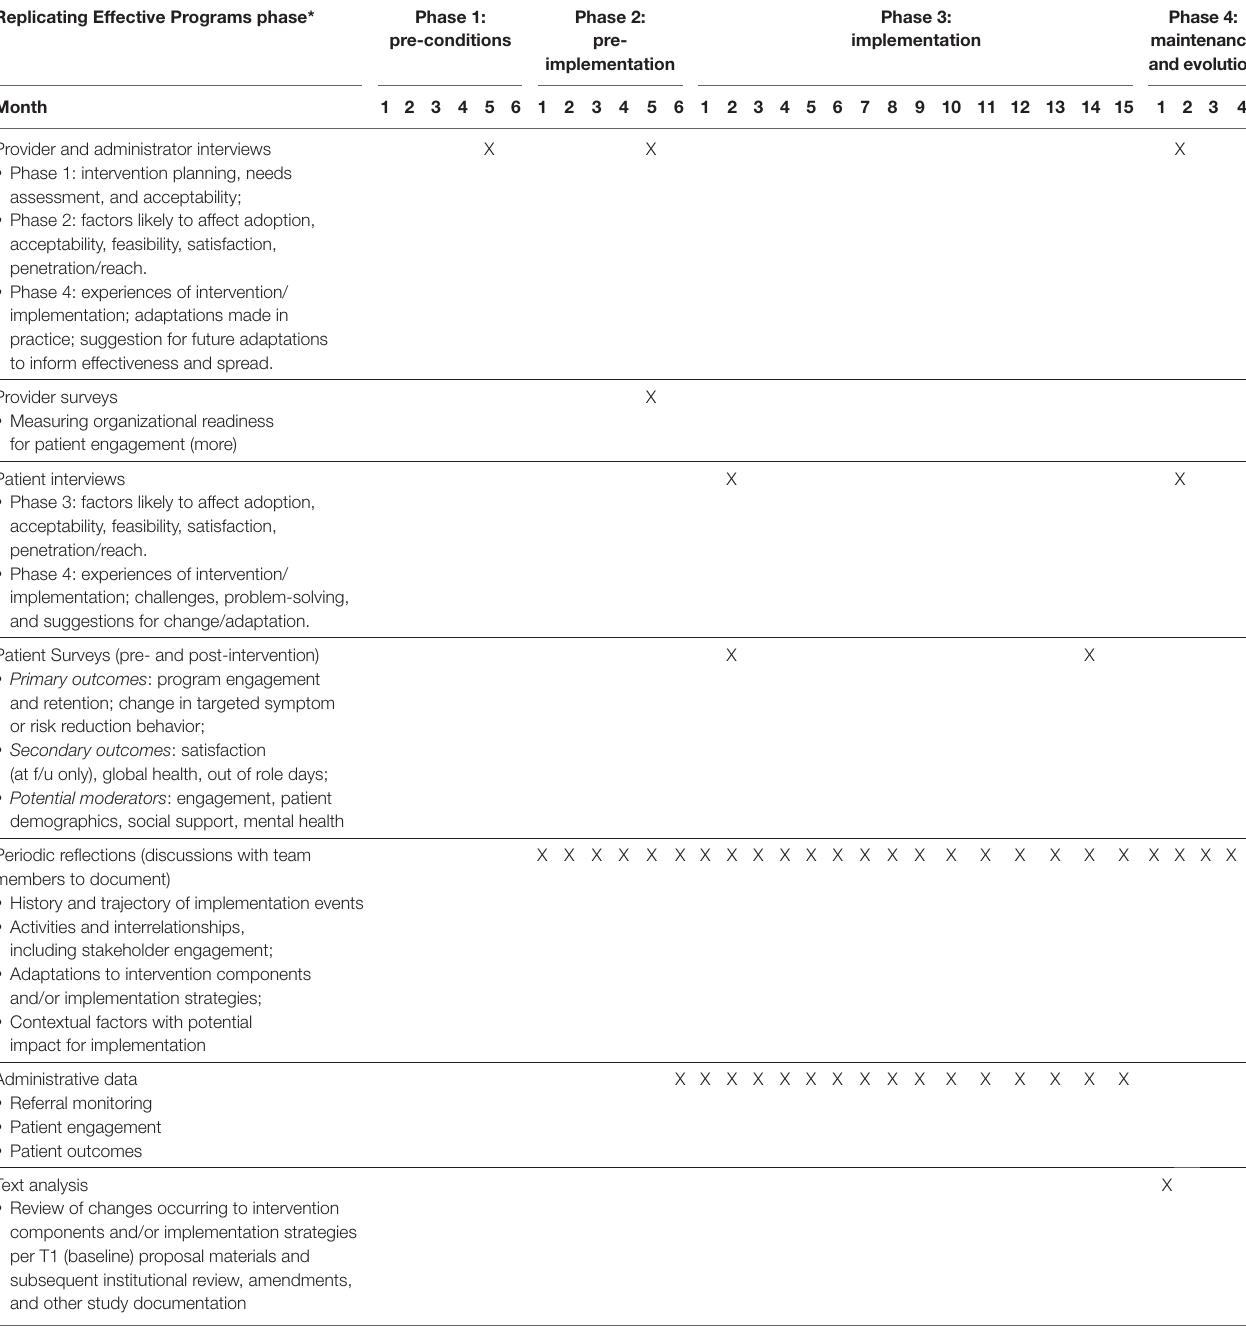
tABle 3 | EMPOWER QUERI implementation evaluation: summary of